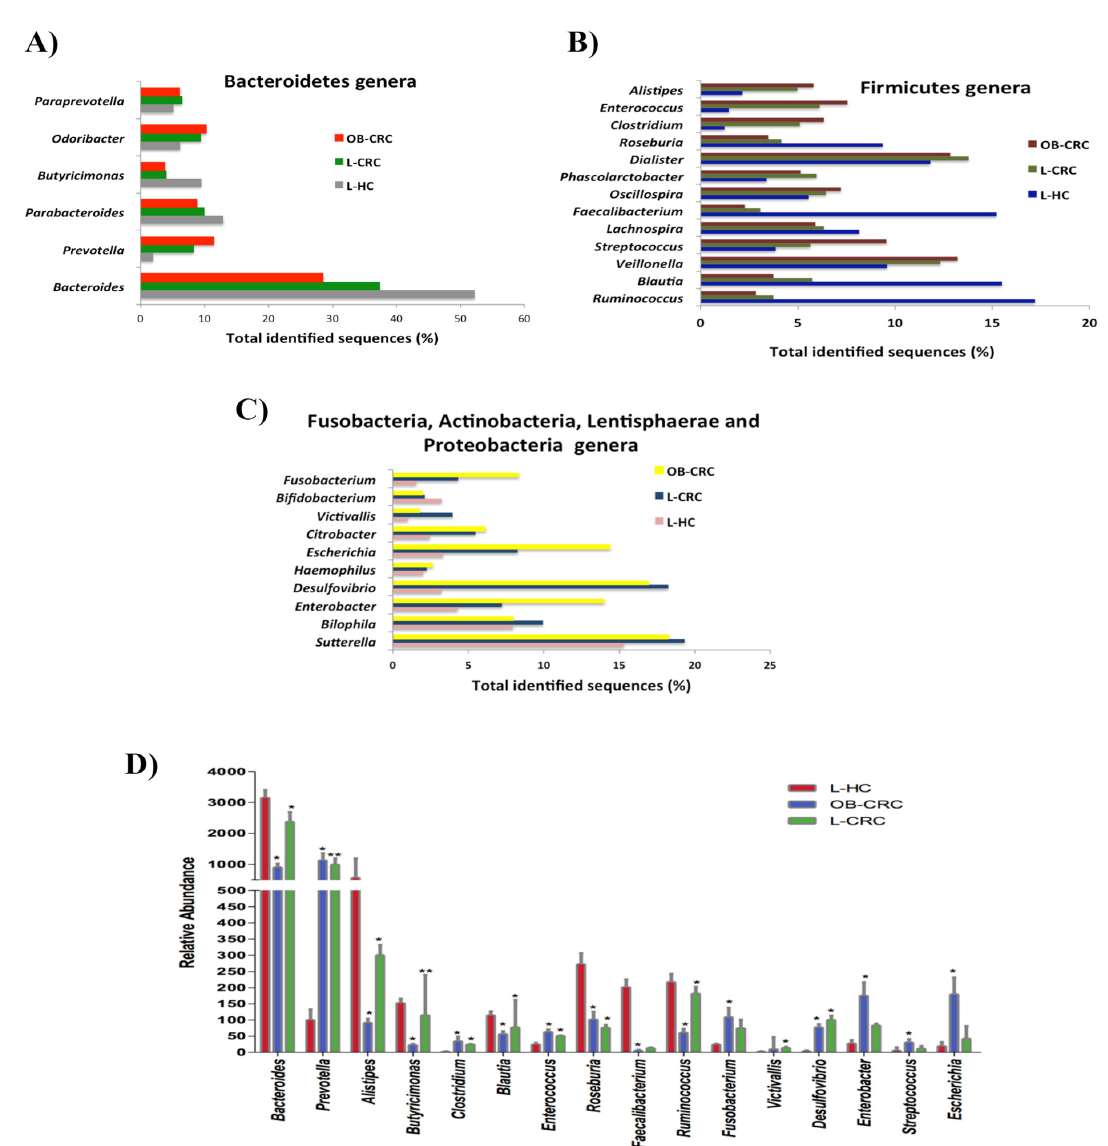
Figure 5. Relative abundance of bacterial genera in the microbiota of OB-CRC, L-CRC, and L-HC controls. ( A ) Bacteroidetes genera, ( B ) Firmicutes genera, ( C ) Fusabacteria, Actinobacteria, Lentisphaerae, and Proteobacteria genera. Data are shown as a percentage of the total identified sequences per group. ( D ) Differentially abundant genera in the stool samples of OB-CRC and L-CRC patients compared to L-HC. * p < 0.05, * * p < 0.001. The bars indicate mean ± SD.